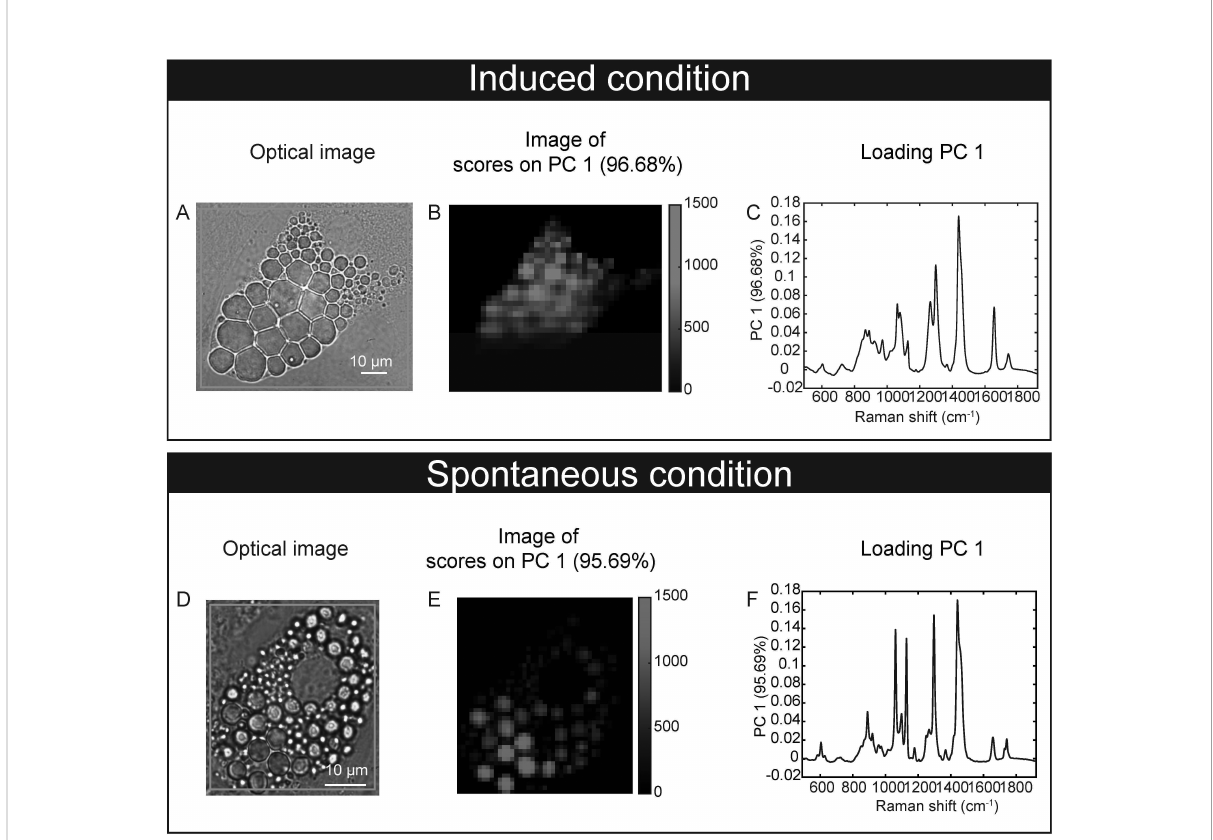
FIGURE 3 Raman microspectroscopy detects unsaturated spectra at the single lipid droplet level in spontaneous and induced adipocytes. (A) An optical image of an adipocyte in the induced condition (iOP9) analyzed by Raman imaging. (B) Raman image of the scores of PC1 in induced condition. Pixels in black represent a score of PC1 equal to zero, which corresponds to the absence of PC1. Pixels in shades of blue correspond to the contribution of PC1. (C) Loading PC1 is characteristic of a spectrum of unsaturated lipid-rich and captures more than 95% of the variation. (D) An optical image of an adipocyte in spontaneous condition (sOP9) analyzed by Raman imaging. (E) Raman image of the scores of PC1 in spontaneous condition. Pixels in black represent a score of PC1 equal to zero, which corresponds to the absence of PC1. Pixels in shades of red correspond to the contribution of PC1. (F) Loading PC1 is characteristic of a spectrum of saturated lipid-rich. The Raman images of the scores and the loadings of PC2 and PC3 capture less than 2% and are presented in supplementary fi les (Figure